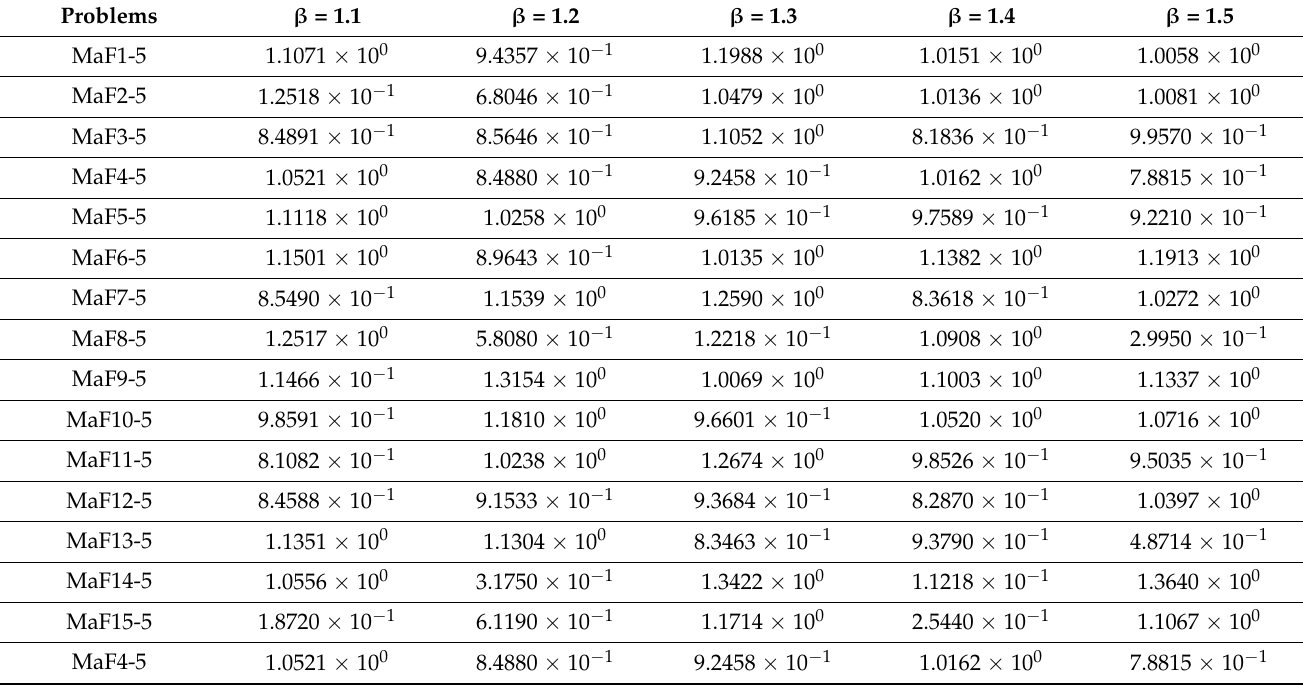
Table 5. IGD mean obtained by Two Arch-D with different β